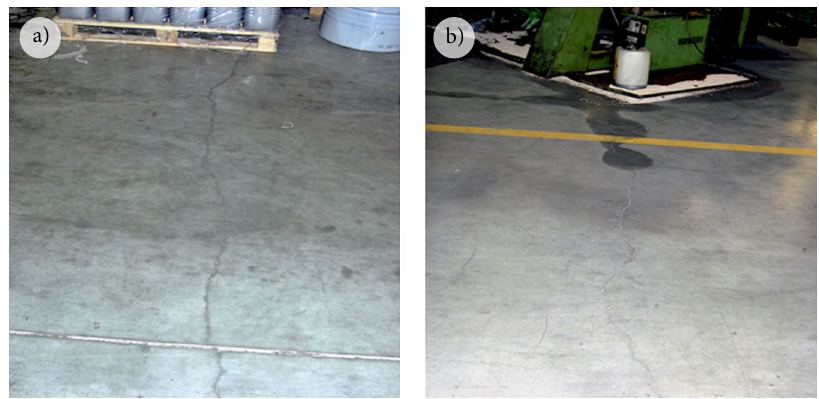
Fig. 4. Examples of damage to the floor of the storage facility the petrochemical industry: a – crack concrete floors; b – oiling and penetration cracks in the floor